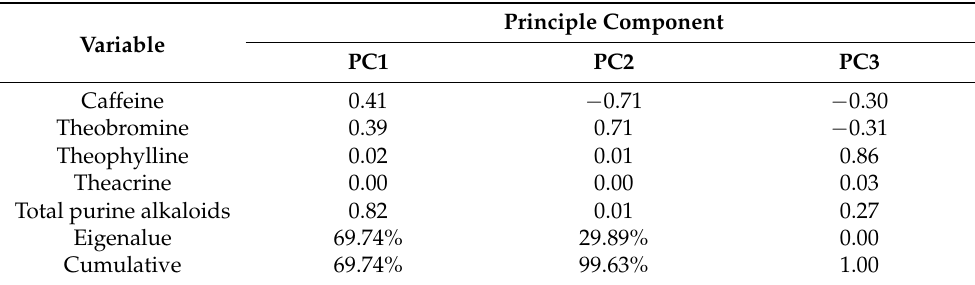
Table 4. Principal component analysis of 126 accessions of three Camellia